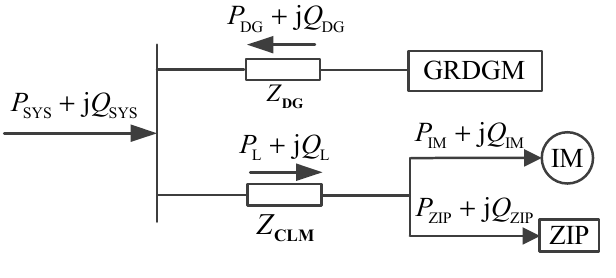
Figure 8. General ADN model.